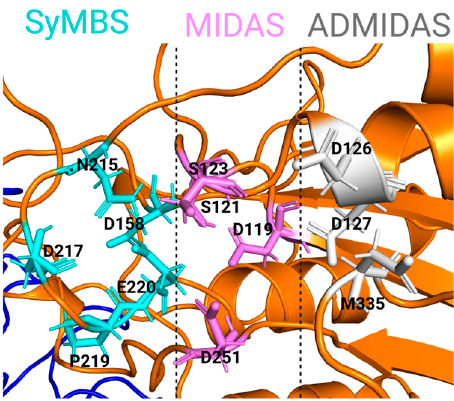
Figure 3. Structure of the metal ion-binding sites of bent α IIb β 3. The metal ion binding sites correspond to the following residues: MIDAS (in pink) includes E 220, S 121, S 123, D 119, D 251; SyMBS (in cyan) includes D 217, N 215, D 158, P 219; ADMIDAS (in grey) includes D 126, D 127, M 335.